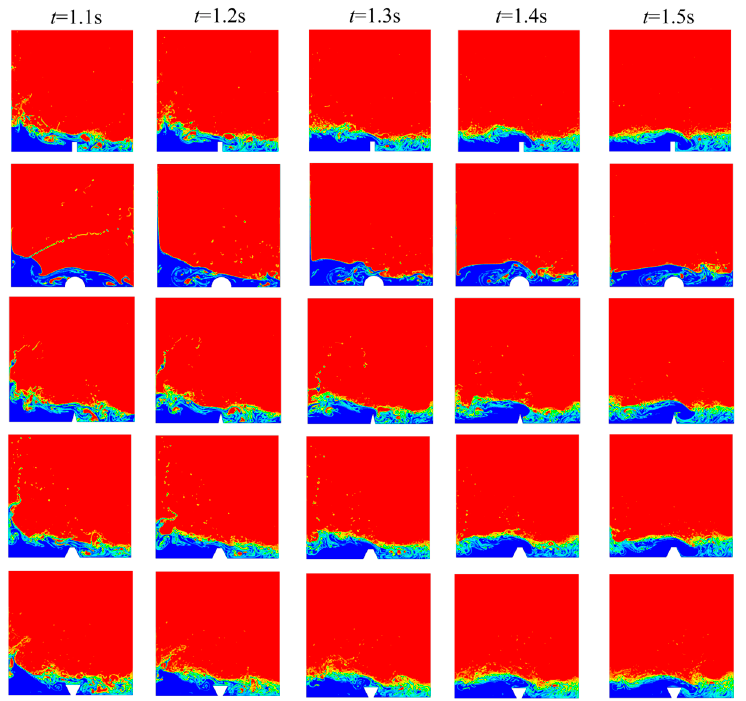
Figure 8. The free surface flow field of obstacles of different shapes at 1.1–1.5 s.